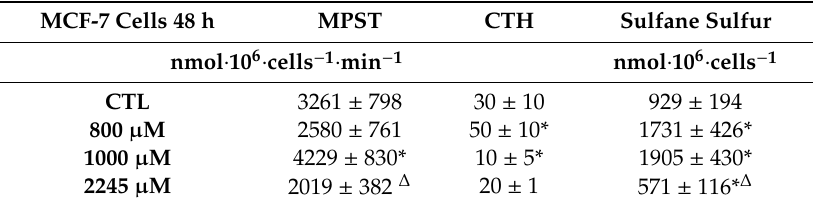
Table 3. The mean value of MPST, CTH activity and sulfane sulfur level in the MCF-7 cell line after a 48 h incubation with